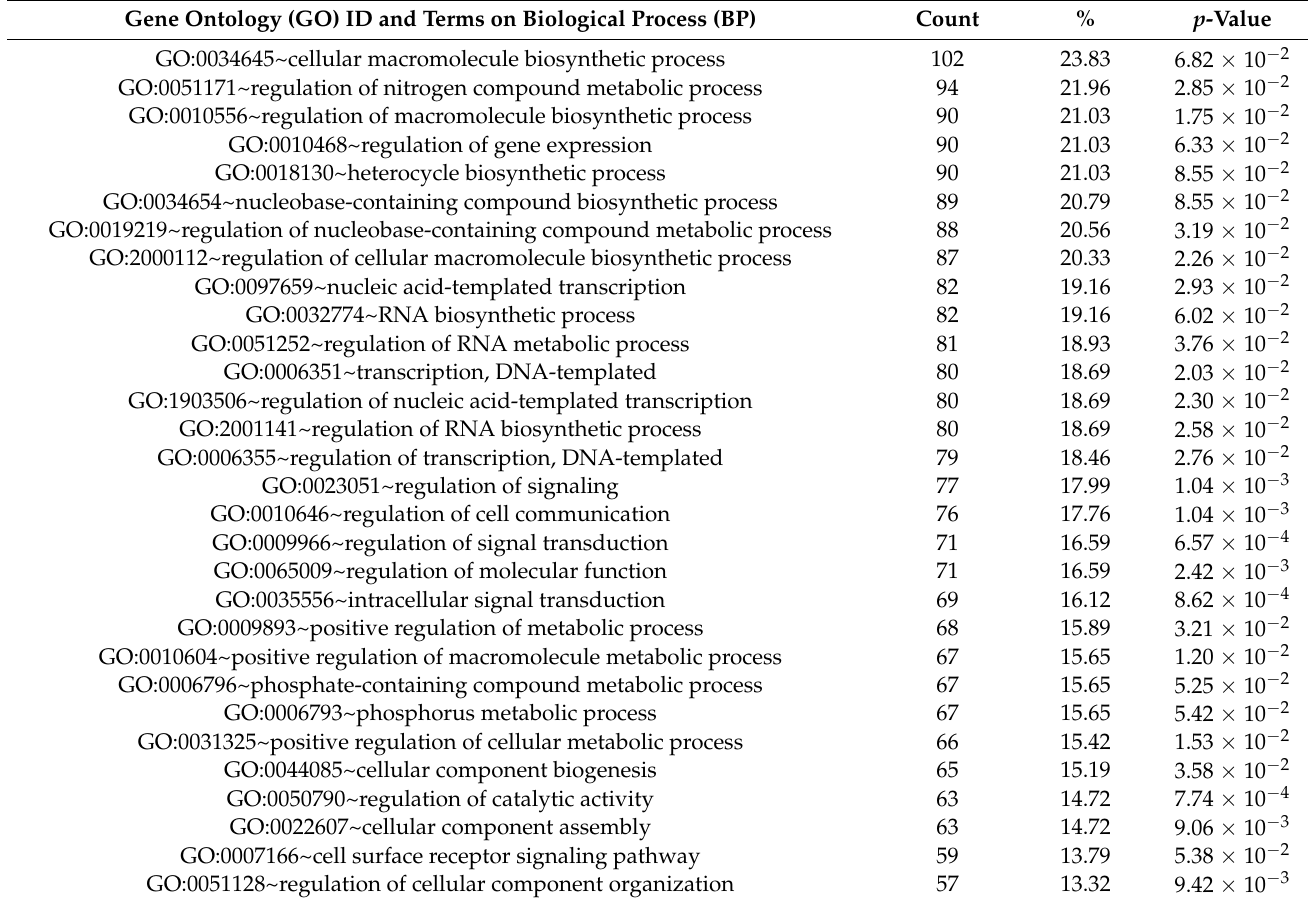
Table 8. The functional analysis of the downregulated genes at 12 h after LLL